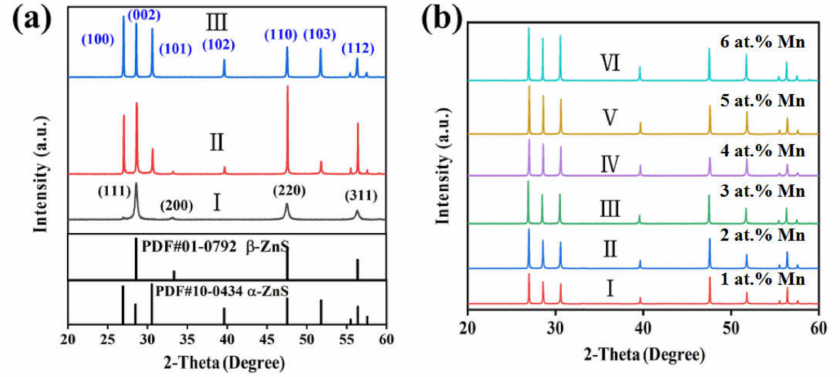
Figure 4. XRD patterns of samples: ( a ) I, β -ZnS; II, α -ZnS; and III, α -ZnS doped with Mn; ( b ) I–III corresponding to doping of approximately 1–6 at.%